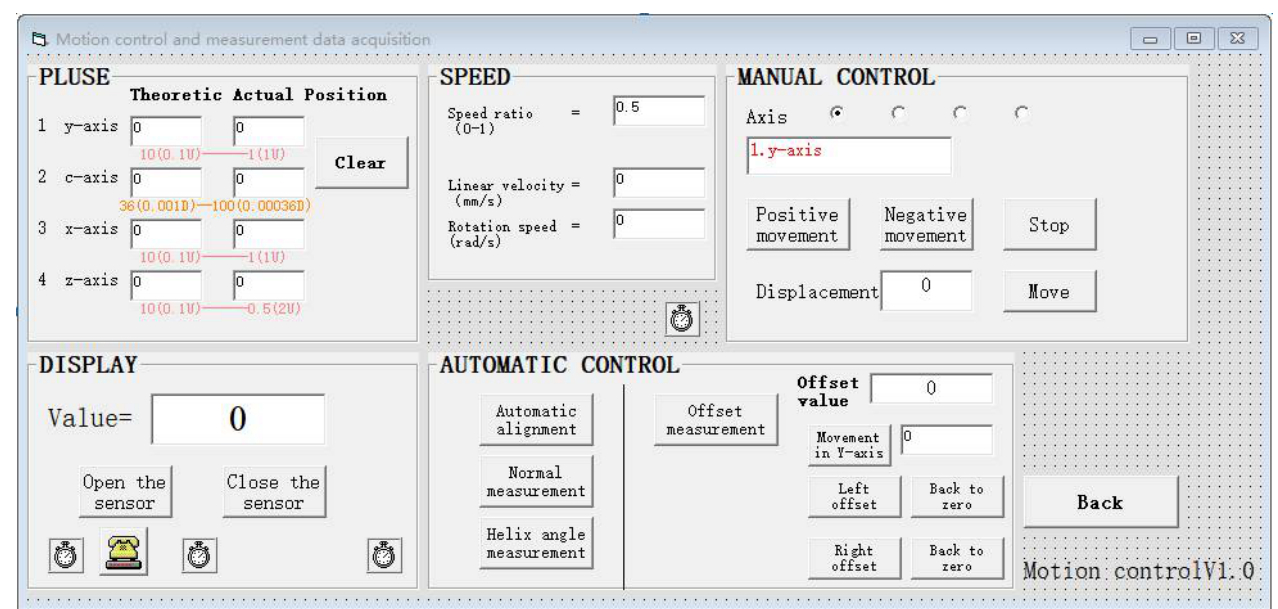
Figure 9. The software system.